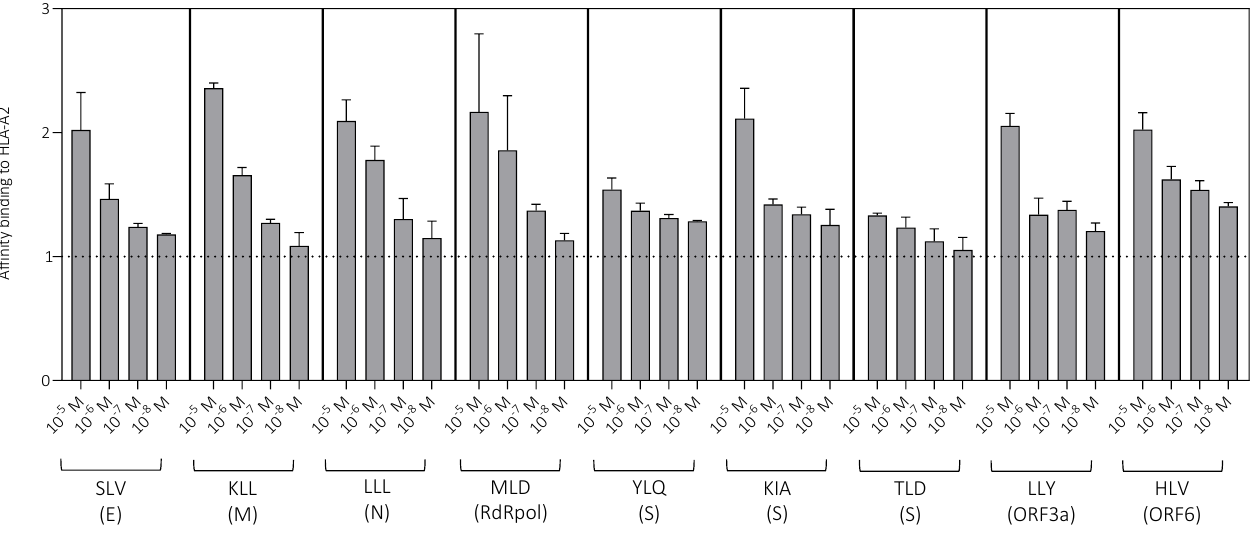
Figure 2. Peptide binding to HLA-A2. Peptide binding affinity was measured across a range of concentrations using a surface stabilization assay. Data are shown as median + SEM. The dotted line indicates no binding (1). E, envelope; M, membrane; ORF, open reading frame; RdRpol, RNA- dependent RNA polymerase; S,